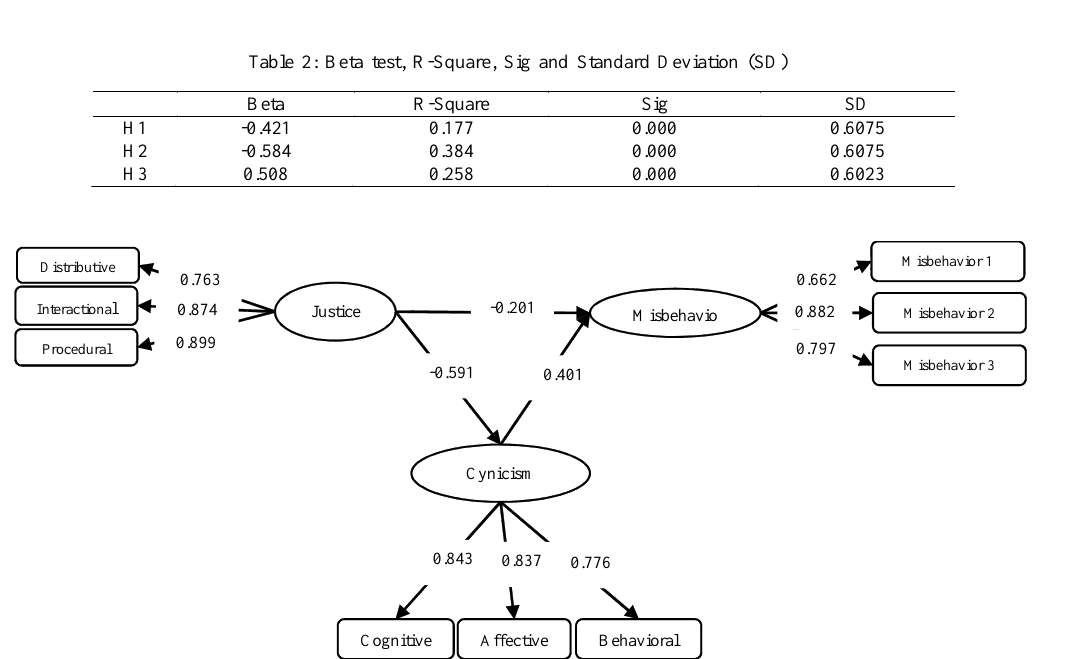
Fig. 1: PLS structural (path analysis) model